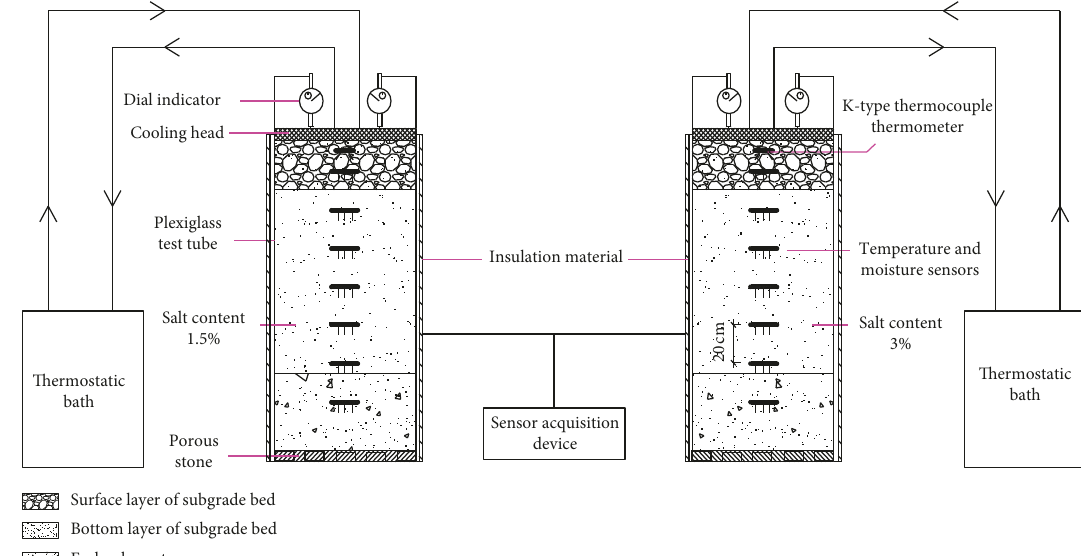
Figure 9: A schematic diagram of the experimental equipment.